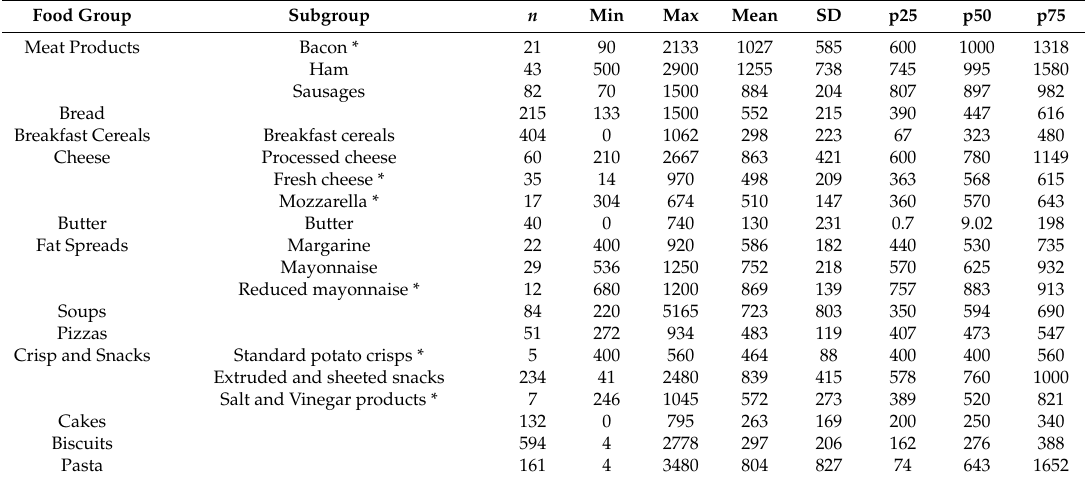
Table 1. Sodium content of processed food groups and subgroups available in the Mexican market (mg/100 g) ( N = 2248).